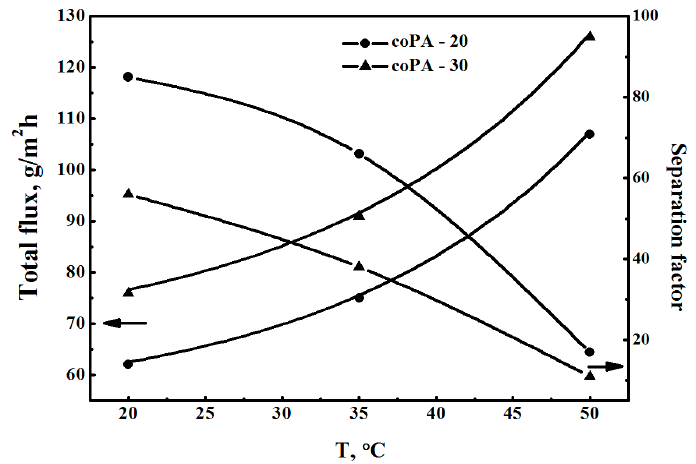
Figure 7. Dependence of total flux and separation factor α Methanol/Toluene on temperature for the pervaporation of azeotropic methanol–toluene (70:30 wt %) mixture through coPA films, 20 ° С .